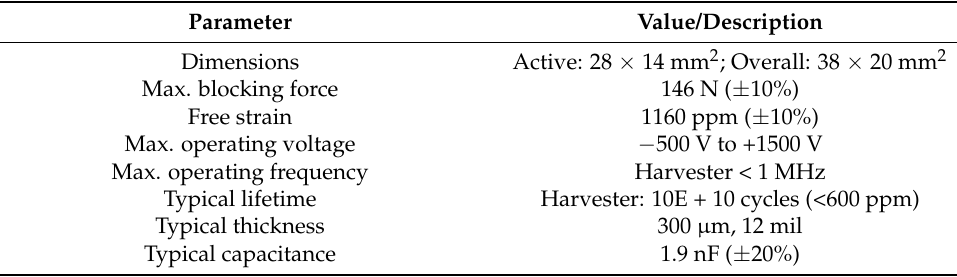
Table 1. Technical parameters of MFC P1